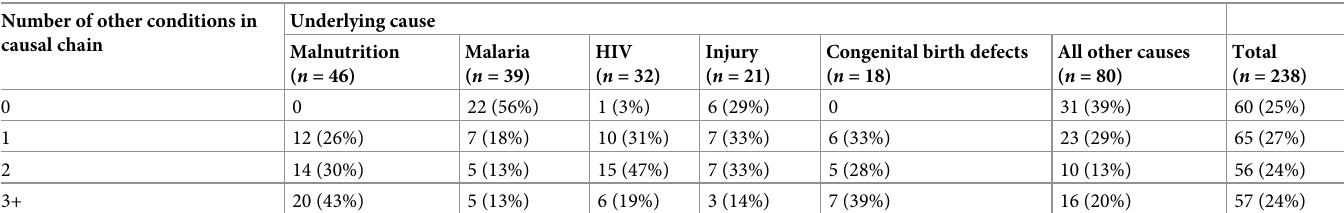
Table 9. Number of conditions in causal chain for child deaths.